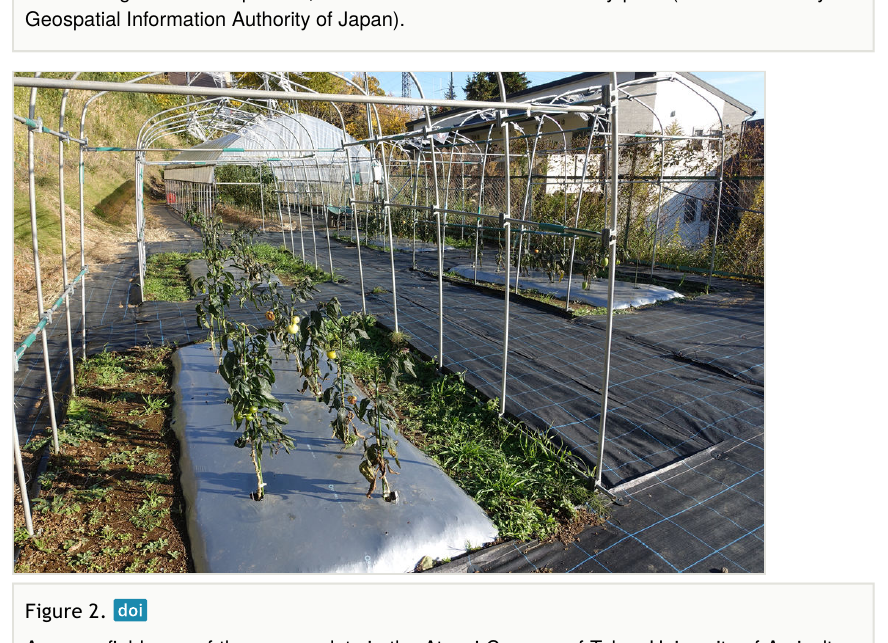
An open fi eld, one of the survey plots in the Atsugi Campus of Tokyo University of Agriculture (TUA), indicated as Plot A in Fig.